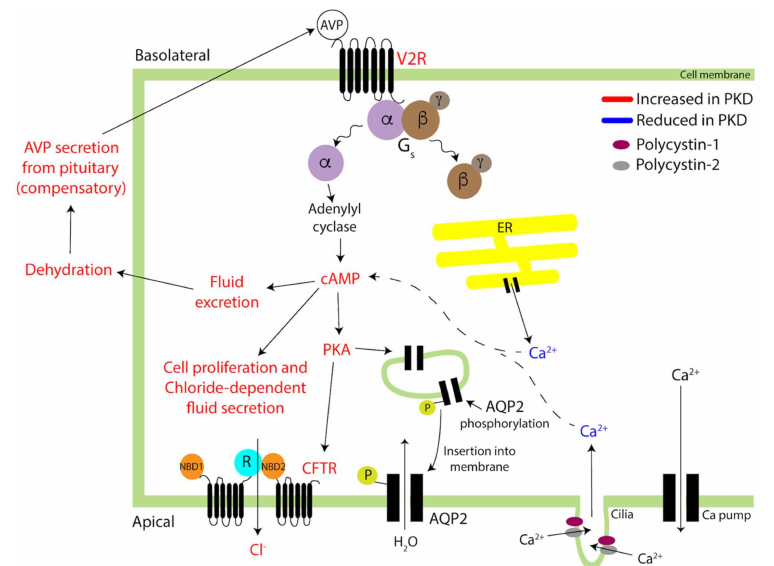
Figure 3. V2R and AVP signaling in normal and autosomal dominant polycystic kidney disease (ADPKD) renal tubule epithelial cells. In normal cells, AVP binding to V2R promotes dissociation of the trimeric G s into its α and βγ subunits. The α subunit triggers adenylyl cyclase (AC)-mediated cAMP synthesis, which activates PKA and phosphorylates AQP2. Phospho-AQP2 is shuttled to the apical cell membrane and water reabsorption increased. In ADPKD (red type), reduced Ca 2+ release from the ER and impaired Ca 2+ import from polycystin 2 at the primary cilia elevate intracellular cAMP (dashed), which in turn increases fluid excretion. Resulting dehydration triggers AVP release from the pituitary. Furthermore, higher than normal intracellular cAMP in ADPKD boosts Cl − trans- port via the cystic fibrosis transmembrane conductance regulator (CFTR) channel that contributes to cystic cell proliferation and chloride-dependent fluid